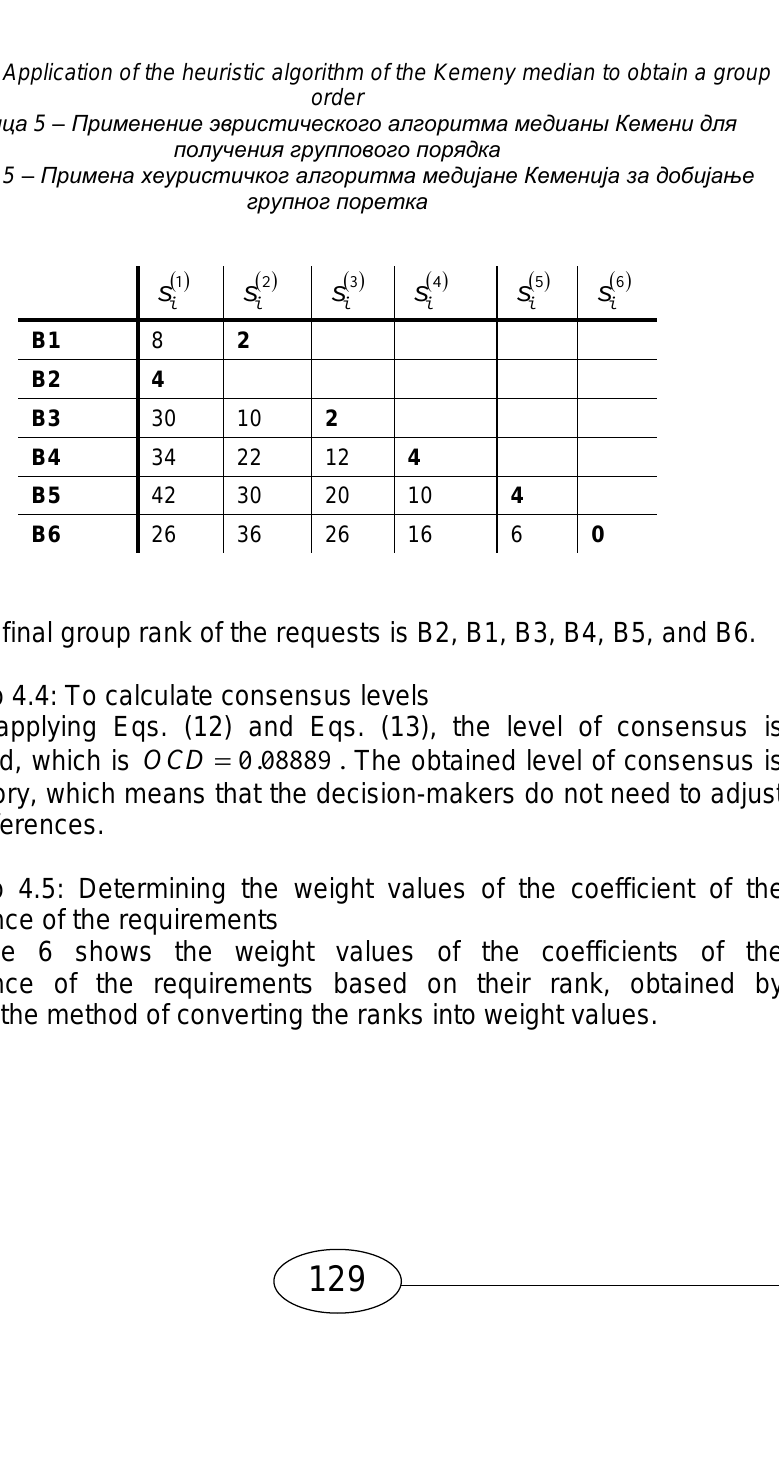
Table 5 – Application of the heuristic algorithm of the Kemeny median to obtain a group